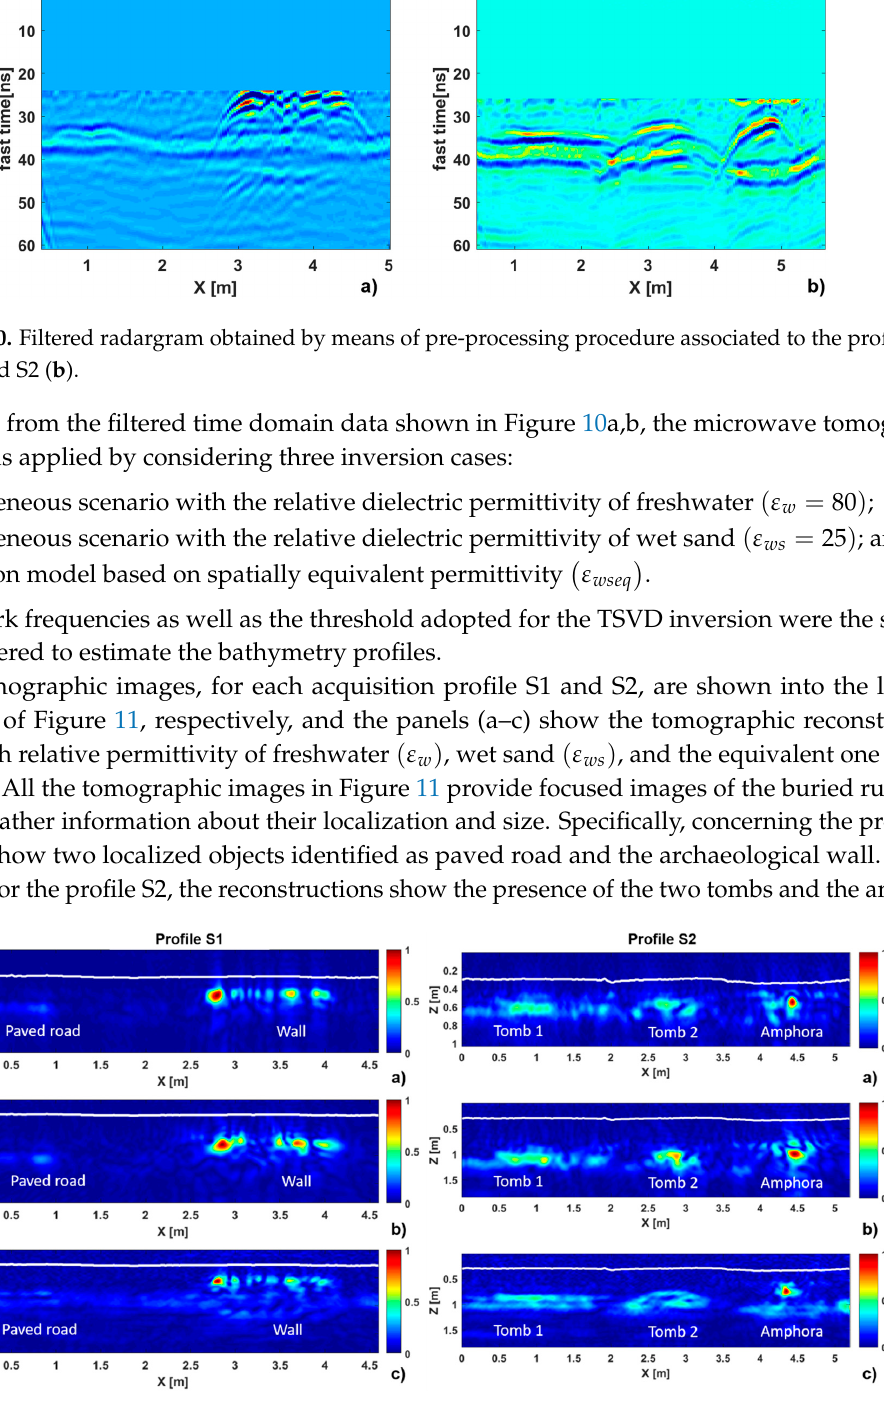
Figure 9. Behavior of the equivalent dielectric permittivity along z -axis for the height h = 0.30 m (blue line) and h = 0.27 m (red line).